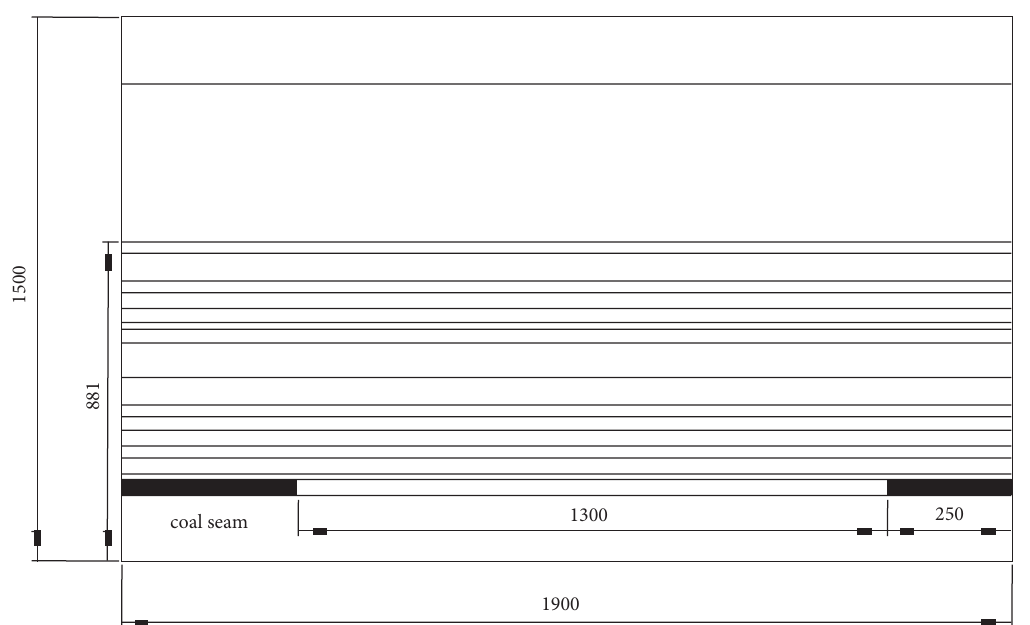
Figure 4: Schematic drawing of similar material model.